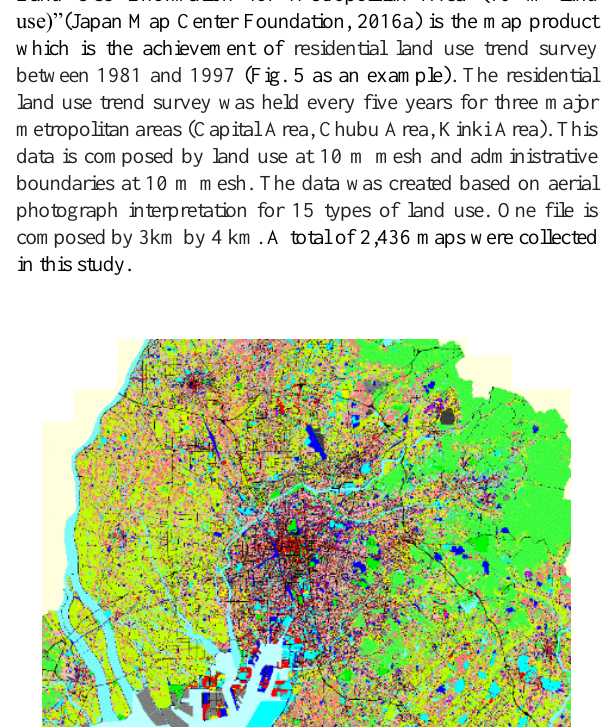
Figure 5. Detailed Digital Land Use Information for